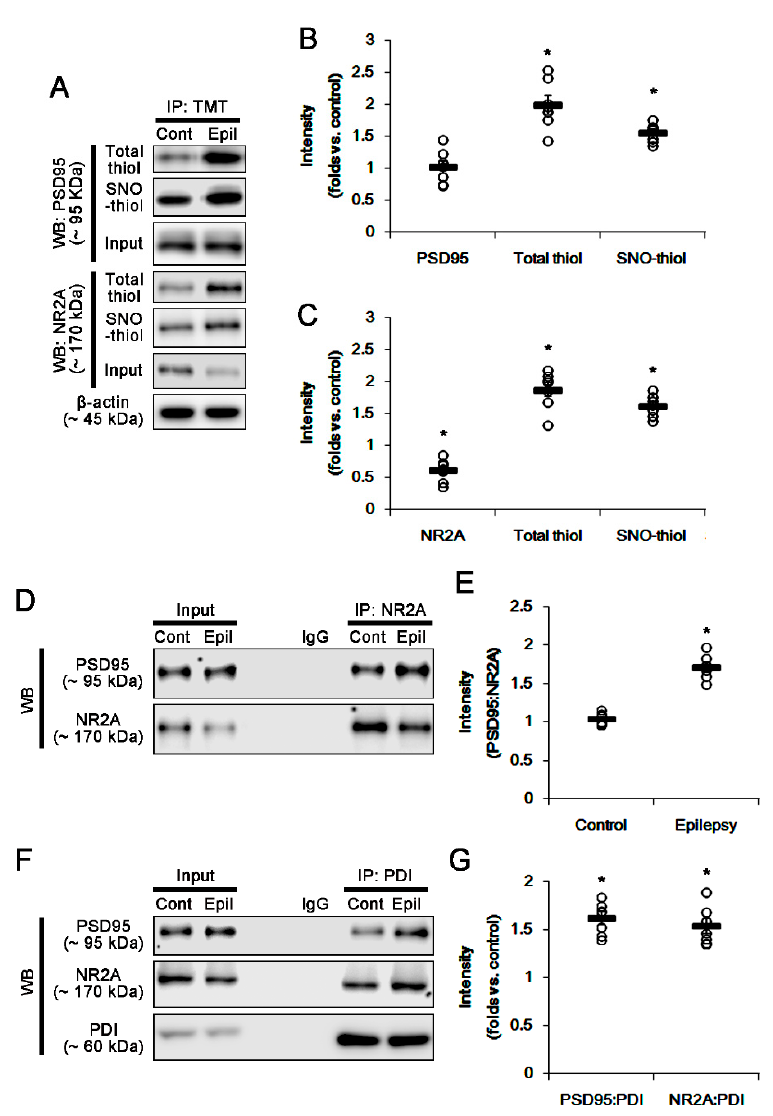
Figure 4. The amounts of total- and SNO-thiols on PSD95 and NR2A, and the bindings of NR2A–PSD95, PDI–PSD95 and PDI–NR2A in the hippocampus of epilepsy rats. ( A ) Representative Western blot for expression and the amounts of total- and SNO-thiol on PSD95 and NR2A. As compared to control animals, epilepsy rats show the increases in the total- and SNO-thiol levels on PSD95 without altered PSD95 expression. In addition, they show the increases in total- and SNO-thiol levels on NR2A, in spite of the reduced NR2A expression. ( B , C ) Quantification of Western blot data. Open circles indicate each individual value. Horizontal bars indicate mean value. Error bars indicate SEM (* p < 0.05 vs. saline, Student’s t -test, n = 7, respectively). ( D ) Co-immunoprecipitation analysis of NR2A–PSD95 interaction in epileptic rats. The NR2A–PSD95 binding is significantly increased, as compared to control animals. ( E ) Quantification of Western blot data. Open circles indicate each individual value. Horizontal bars indicate mean value. Error bars indicate SEM (* p < 0.05 vs. saline, Student’s t -test, n = 7, respectively). ( F ) Co-immunoprecipitation analyses of PDI–PSD95 and PDI–NR2A co-assemblies in epileptic rats. The bindings of PDI–PSD95 and PDI–NR2A are elevated in epileptic rats, as compared to control animals. ( G ) Quantification of Western blot data. Open circles indicate each individual value. Horizontal bars indicate mean value. Error bars indicate SEM (* p < 0.05 vs. saline, Student’s t -test, n = 7, respectively).